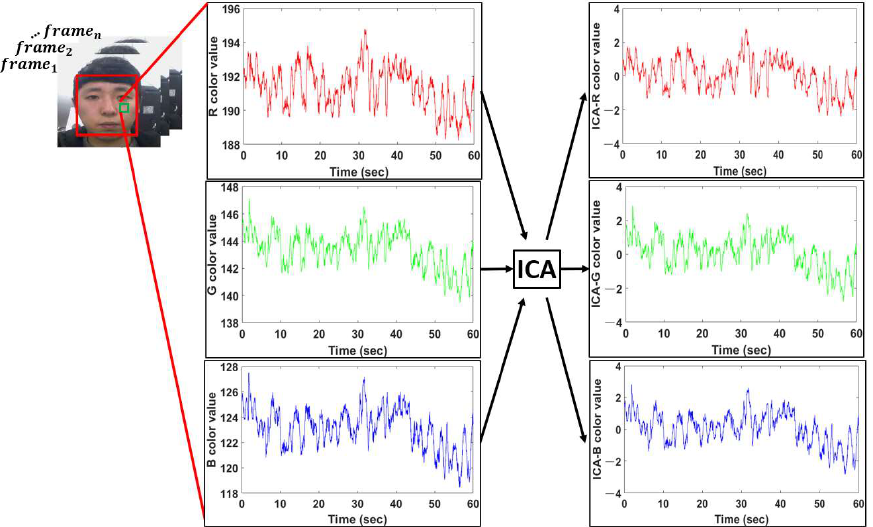
Figure 14. RGB components calculated by applying ICA to RGB color data.